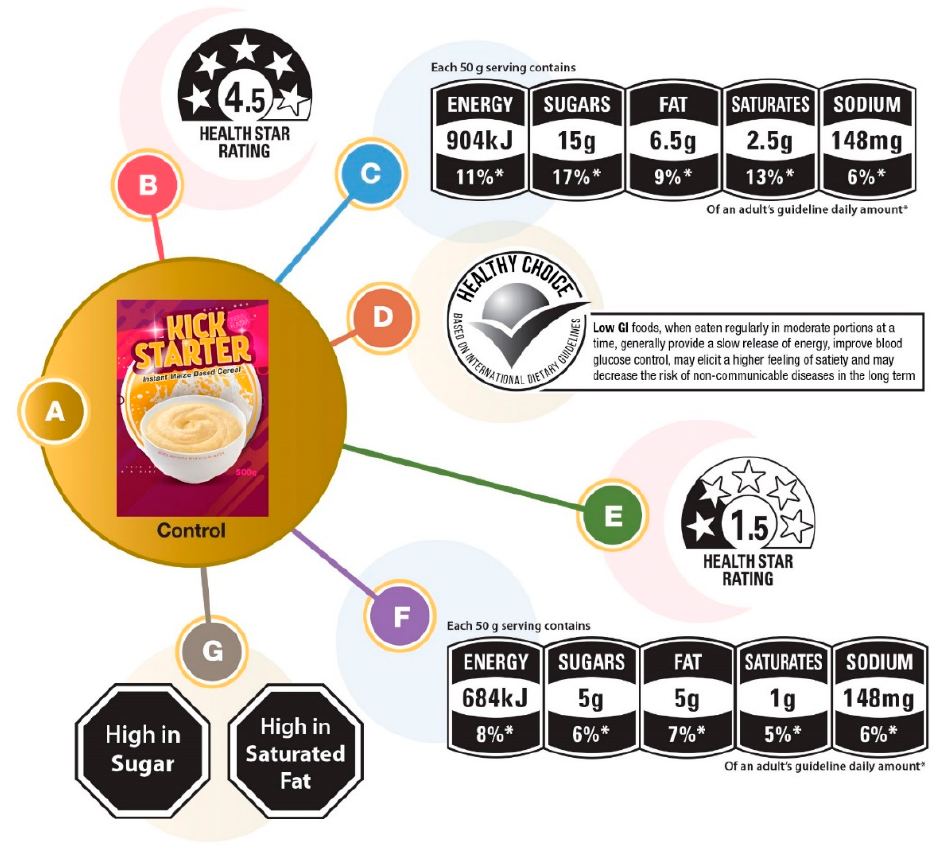
Figure 2. Packaging design of fictitious cereal product and FOP labeling used in the consumer survey. *: of an adult’s Guideline Daily Amount.